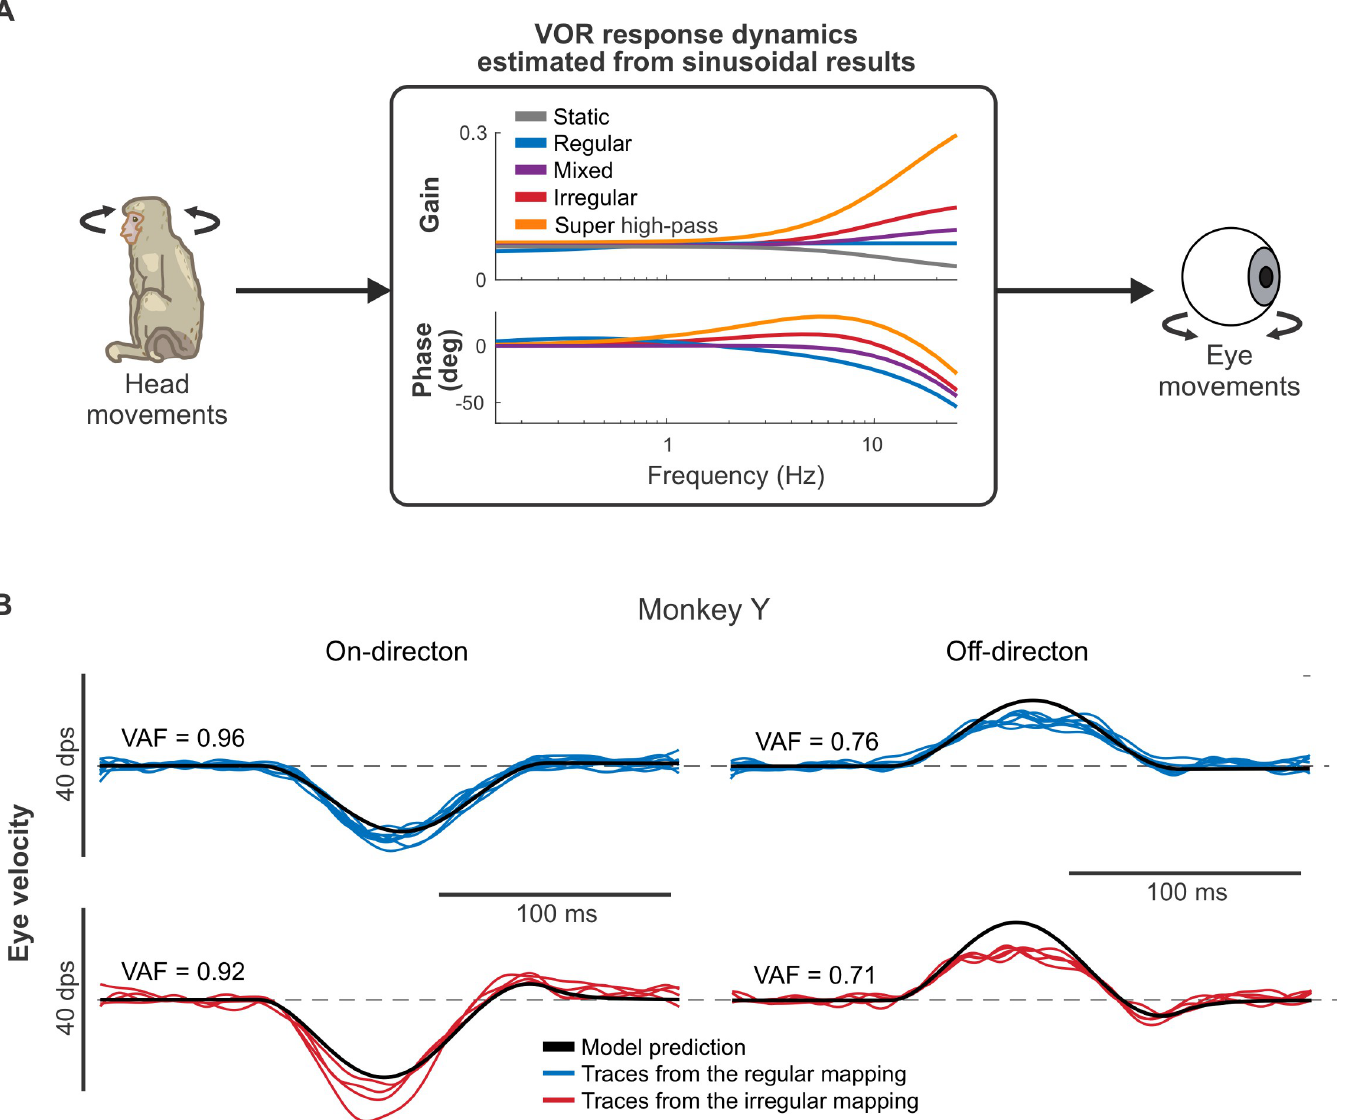
Fig 5. Eye movement responses to virtual transient stimulation can be predicted by those to sinusoidal stimulation. ( A ) The schematic of the model that estimates the VOR response dynamics of each monkey using a simple linear transfer function (see Materials and methods). ( B ) The model prediction (black line) of the evoked eye movements during transient head movements in the on (left column) and off (right column) directions for the regular (top row) and the irregular (bottom row) mappings.